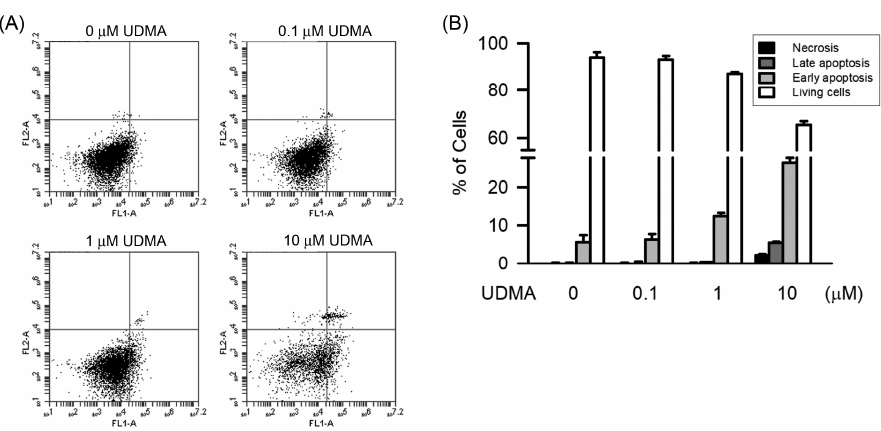
Figure 2. UDMA induced apoptosis and necrosis in RAW264.7 macrophages. The portion of apoptosis and necrosis was measured by Annexin V ‐ FITC and PI assays using flowcytometry. ( A ) Cells were incubated with UDMA at concentrations of 0, 1, 10, and 100 μ M for 24 h at 37 °C. The upper left quadrant (Annexin V − / + ) is representative of necrosis; the upper right and lower right quadrants (Annexin V + /PI + and Annexin V + /PI − ) are representatives of apoptosis; and the lower left quadrant (Annexin V − /PI − ) is representative of living cells. ( B ) Quantitatively, the percentage of necrotic cells, viable cells, and apoptotic cells were calculated and analyzed. Data are expressed as mean ± SD (n = 5). * P < 0.05 is considered significant compared with the control group.